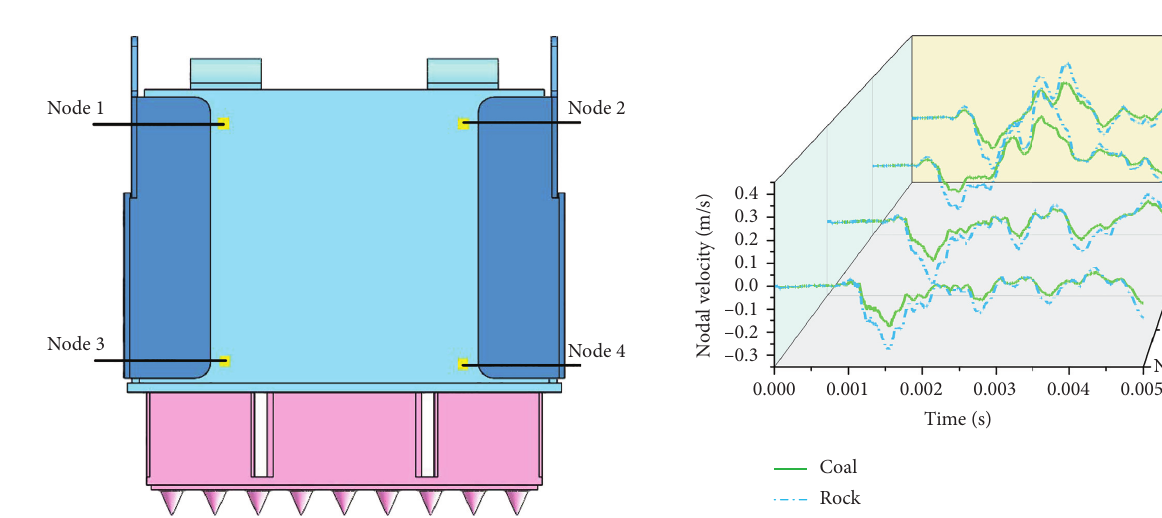
Figure 8: Nodal position in the tail beam noncollision contact zone.